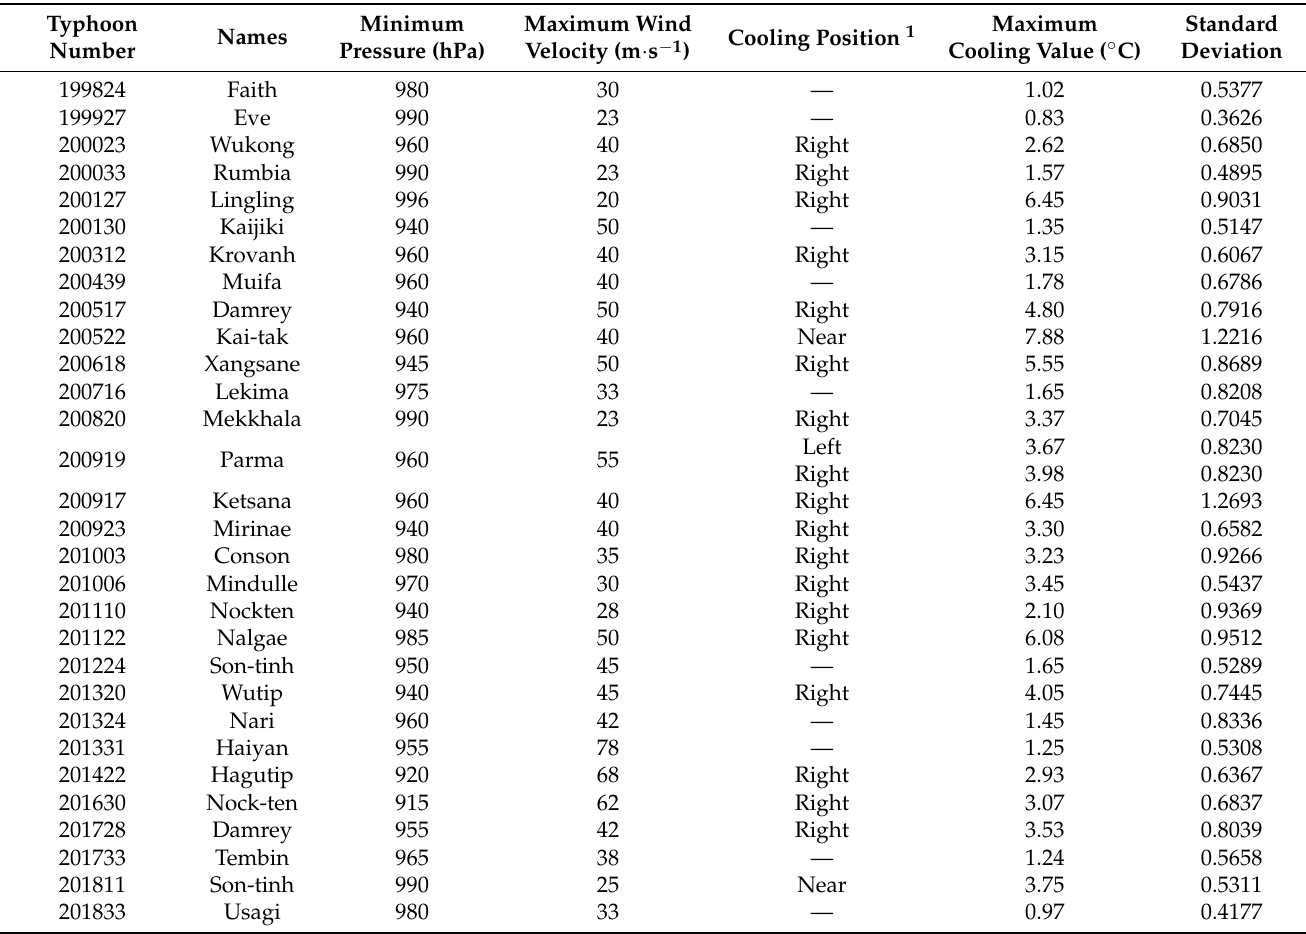
Table 2. Statistical information of typhoon track